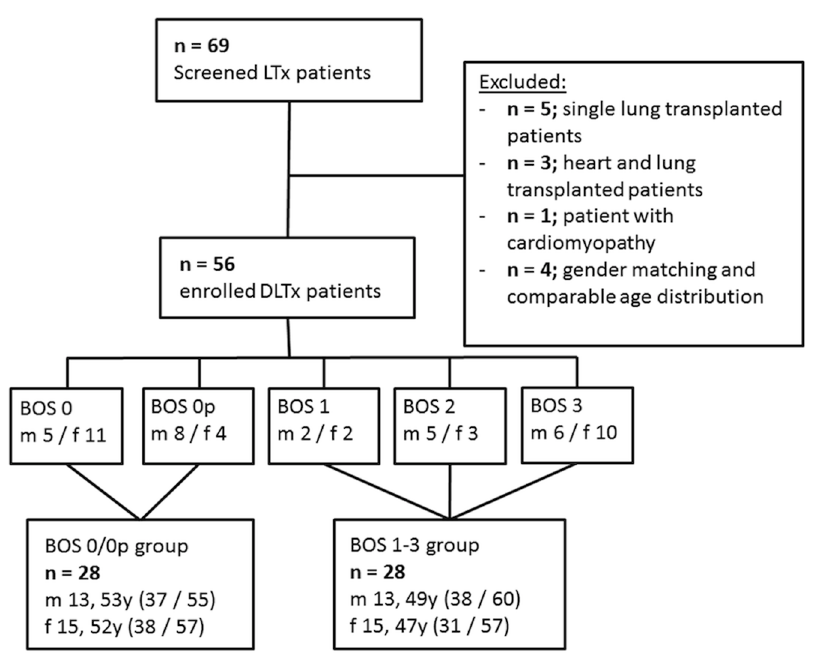
Figure 1. Flowchart of patients included in the study. LTx 5 lung transplantation, DLTx 5 double lung transplantation, BOS 5 bronchiolitis obliterans syndrome, m 5 male, f 5 female, y 5 years; median and 25; 75 interquartile range for age